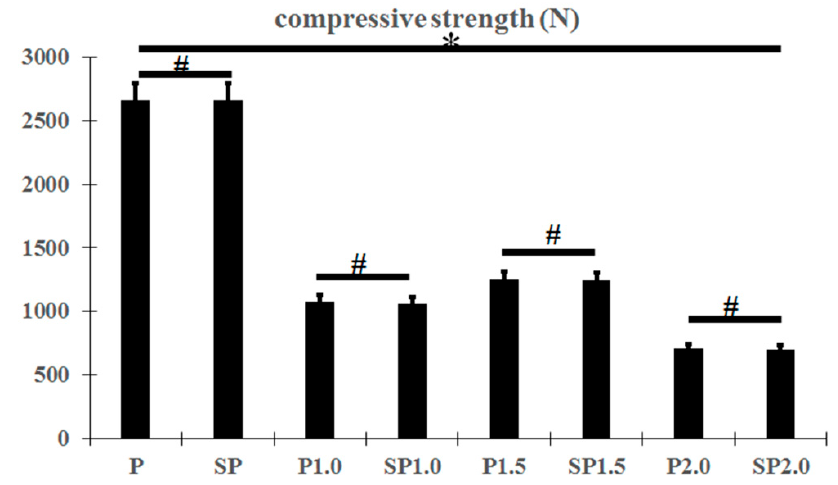
Figure 4. Compressive strength of peek specimens. * p < 0.05, # p > 0.05.